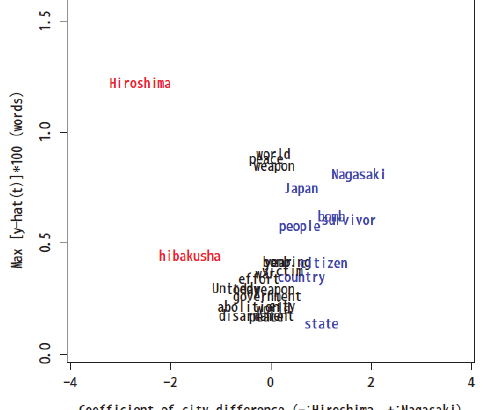
Fig. 12. Scatter plot of keyword's frequency by cluster in